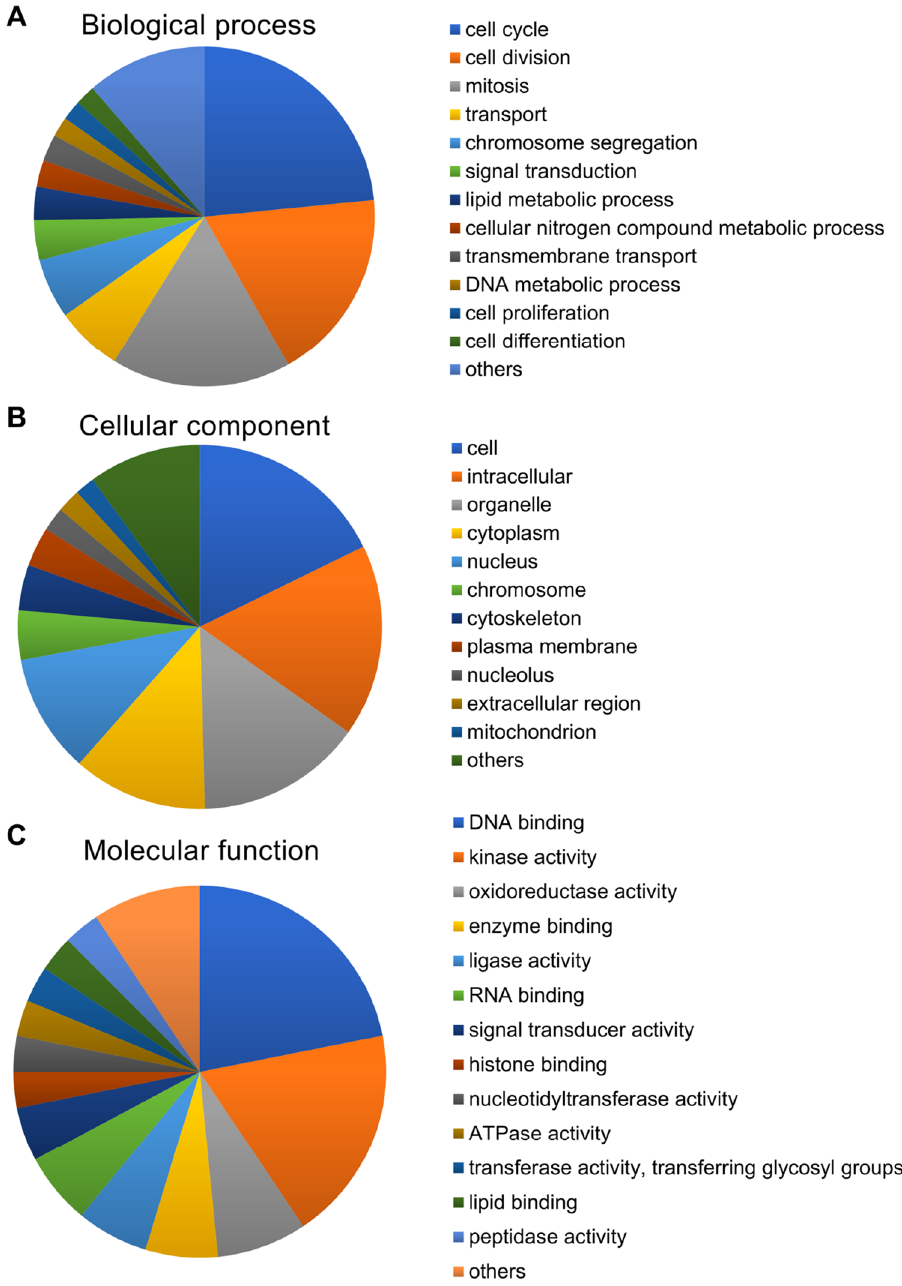
Figure 1. Gene ontology analysis of the genes that were upregulated in the pancreatic islets of 10-week-old db/db mice treated with luseogliflozin. Upregulated genes in the luseo group in the microarray analysis were functionally categorized based on gene ontology annotation. ( A ) Biological process. ( B ) Cellular component. ( C ) Molecular